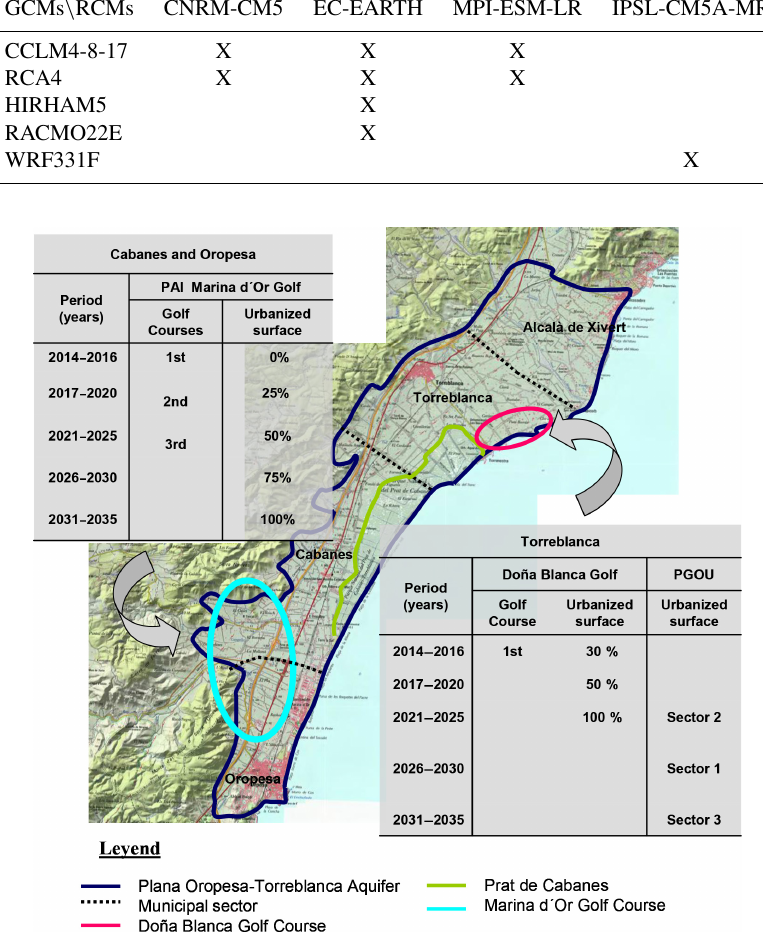
Figure 5. Future land use scenarios in